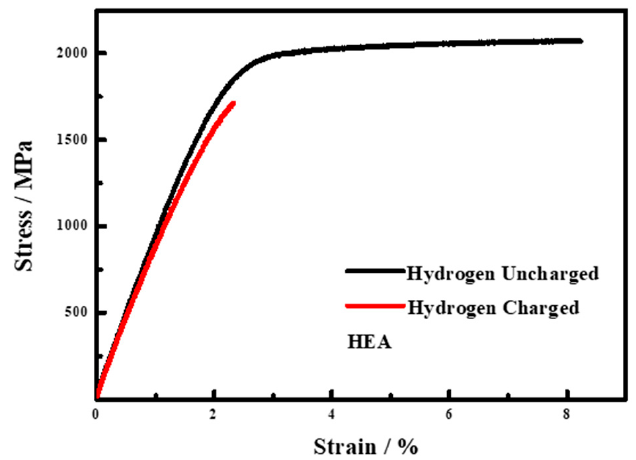
Figure 1. Stress-strain curves of Al 0.5 Cr 0.9 FeNi 2.5 V 0.2 obtained by SSRT tested at room temperature with and without hydrogen charging.